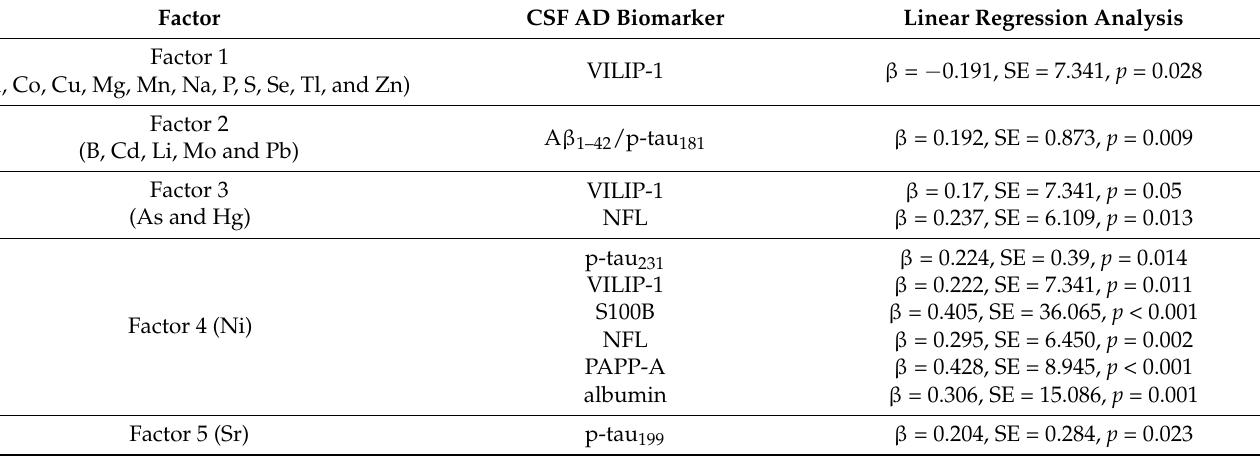
Table 5. Results of linear regression analysis; comparison of factors obtained by PCA of plasma macro- and microelements with CSF AD biomarkers.